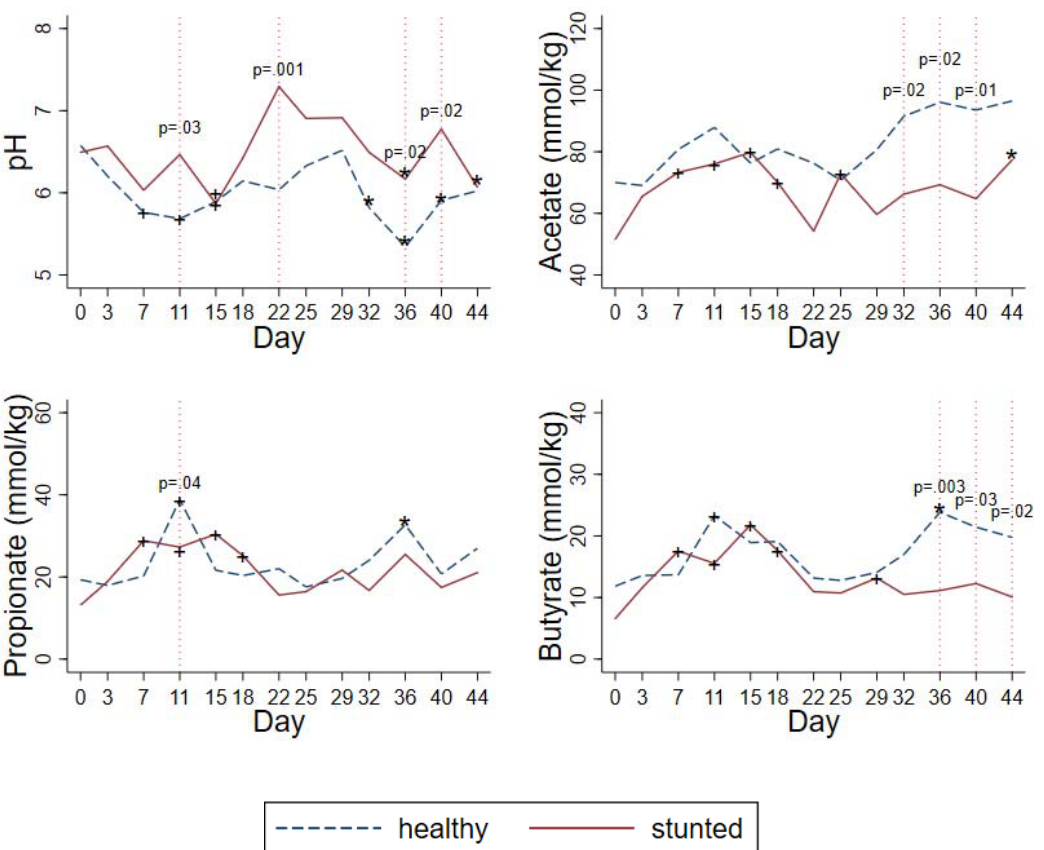
Figure 3. Baseline adjusted fecal pH and SCFA showing differences between healthy and stunted children (n = 20). Values are adjusted mean. + p < 0.05 versus day 0. * p < 0.05 versus day 29.